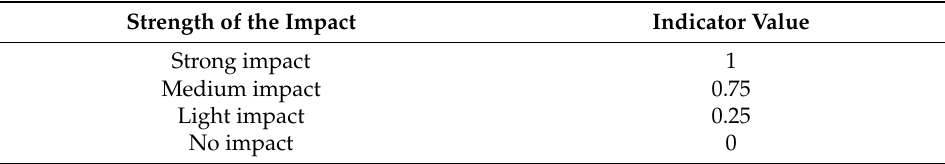
Table 1. Strength of the landscape